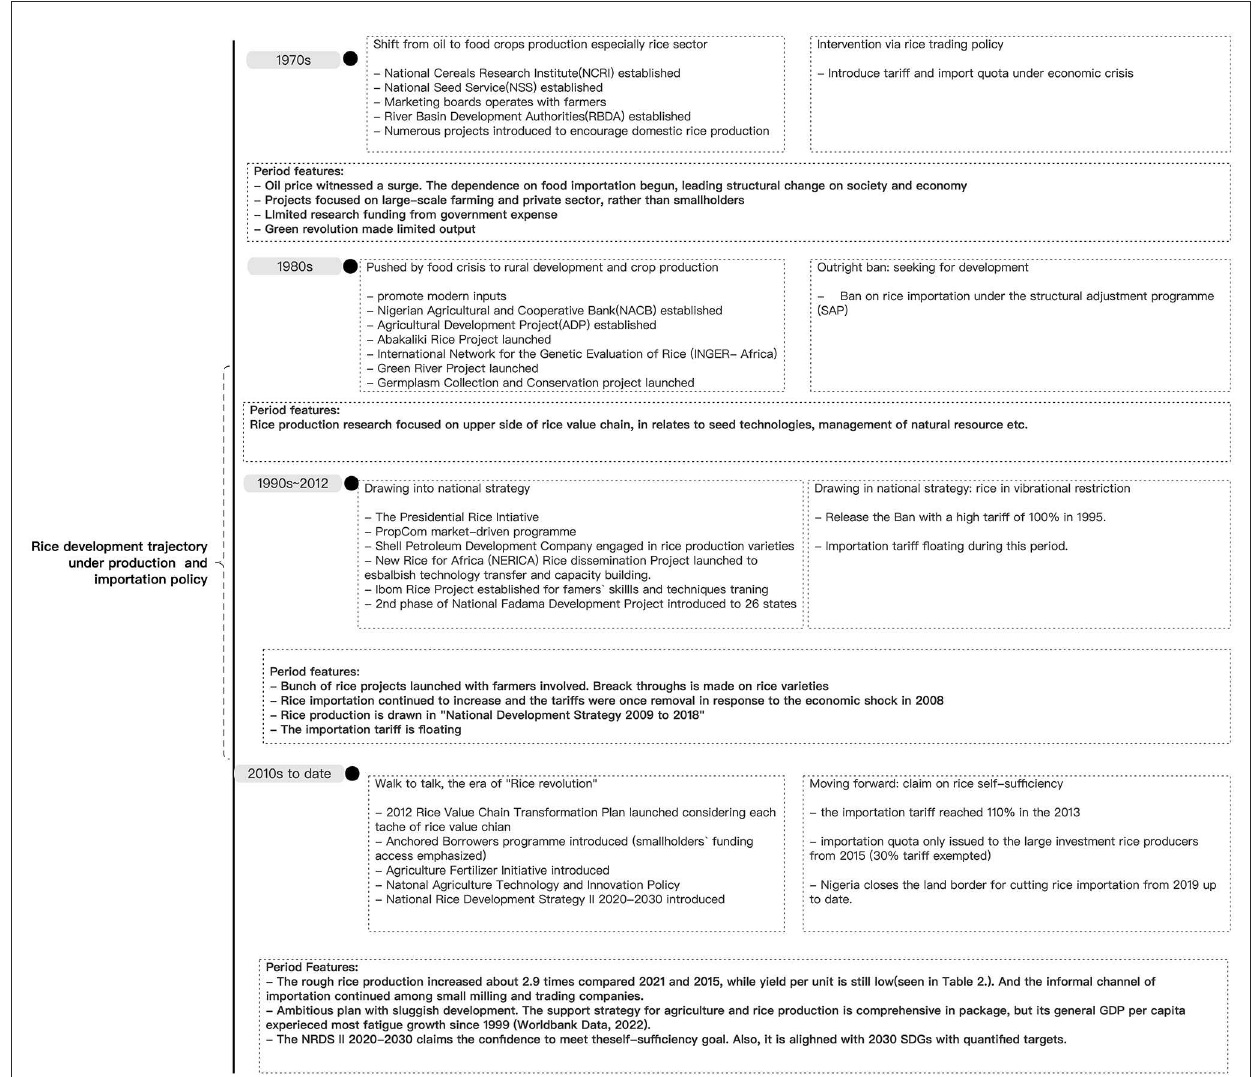
FIGURE1 The rice development trajectory intendes to help grasp the evolution of rice production policies from the formation of a national strategic framework in Nigeria since 1970. At the sametime, the rice importation policy is illustrated along the domestic rice development footprint. In general, it outlines the change of rice narratives in Nigeria through the past decades. This is of great significance for current policy adjustment or decision-making, it highlights, first, before the 1990s, the emphasis on food was due to international oil fluctuations, not an active strategic plan. International agricultural cooperation has been carried out extensively. But the projects are fragmented. Third, rice is becoming the centerpiece of National Strategy. The top-level design of the National Agricultural Development Strategy has aligned with the United Nations 2030 Sustainable Development Goals. The framework sets more ambitious targets for the future of rice development. Source: the information collected and compiled is based on multiple studies (Emodi and Madukwe, 2008; Terwase and Madu, 2014; Gyimah-Brempong et al., 2016; Abbas et al., 2018; Aliu, 2018; Theresa et al., 2020; Muhammed and Iliyasu,